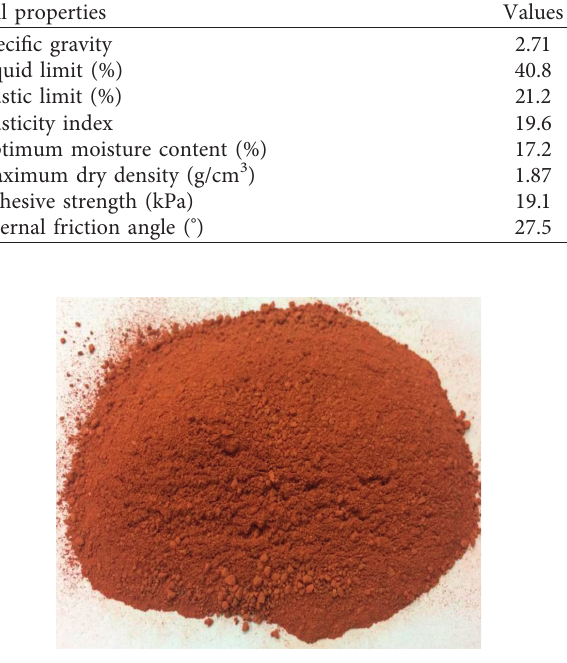
Figure 1: Tested soil.